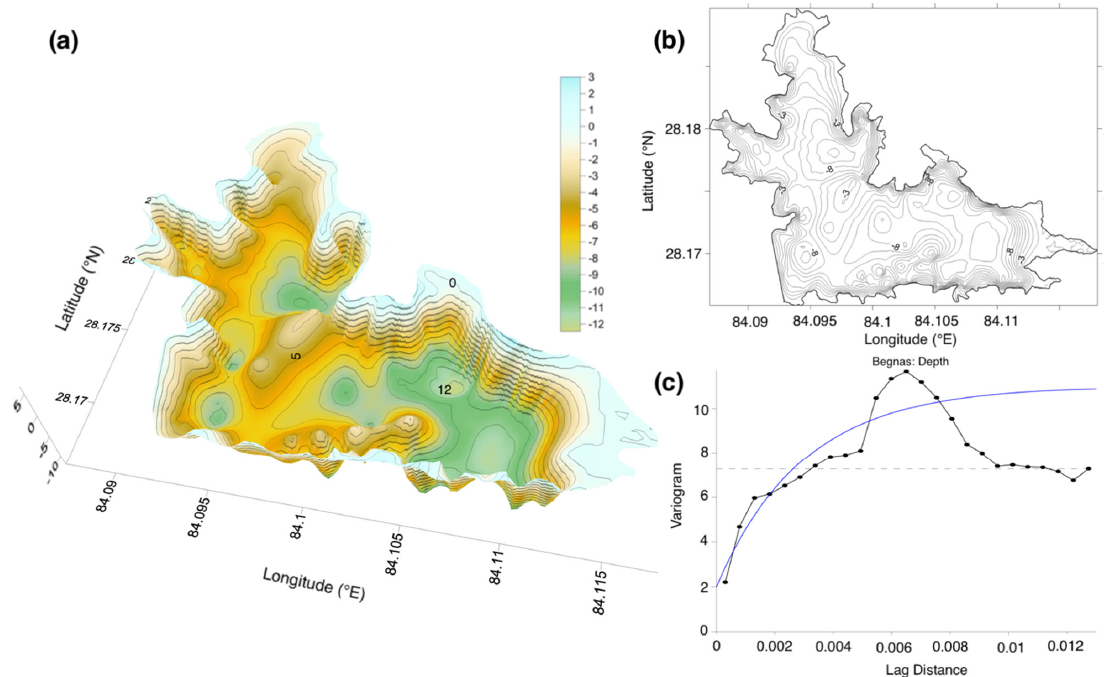
Figure 4. Variogram and bathymetry map of Begnas Lake: ( a ) 3D visualization of the lake showing the underwater lake topography, ( b ) 2D contour representation of the lake surface, and ( c ) variogram model fitting for the surveyed depth points for the kriging interpolation.